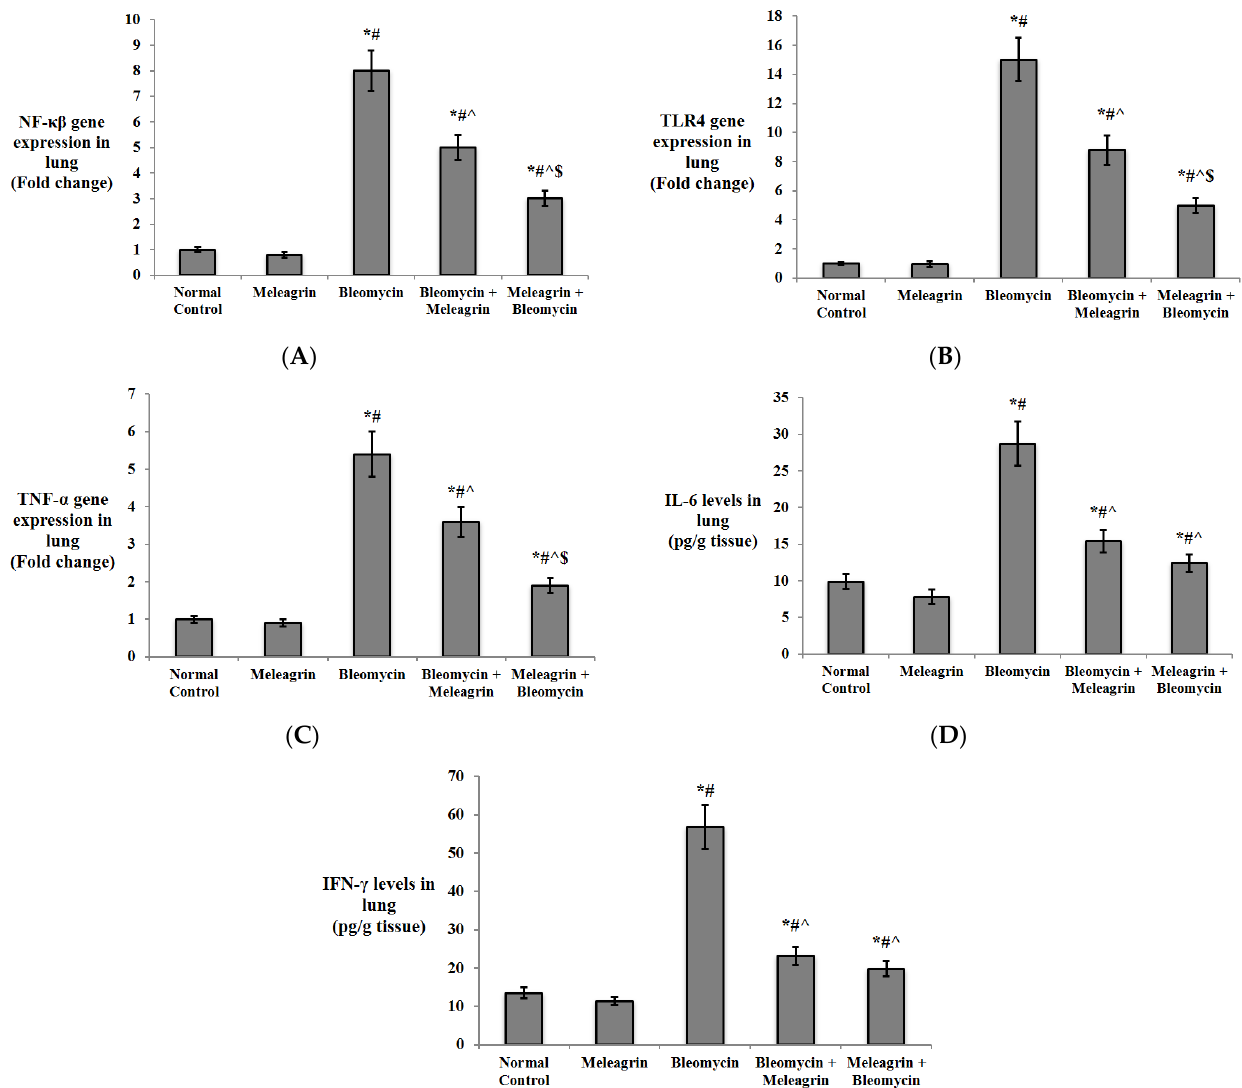
Figure 5. The effect of meleagrin on the inflammatory markers: ( A ) NF- κ B gene expression, (B) TLR4 gene expression, ( C ) TNF- α gene expression, ( D ) IL-6 levels and ( E ) IFN- γ levels in the lung tissue of the experimental mice. NF- κ B = nuclear factor kappa B; TLR4 = toll like receptor 4; TNF- α = tumor necrosis factor-alpha; IL-6 = interleukin-6; IFN- γ = interferon gamma. Data are expressed as mean ± SD and analyzed using one-way ANOVA followed by Bonferroni’s post hoc test ( n = 8). * significantly different vs. the normal control group; # significantly different vs. the meleagrin group; ^ significantly different vs. the bleomycin group; $ significantly different vs. the bleomycin + meleagrin group. Differences were considered significant at p < 0.05.